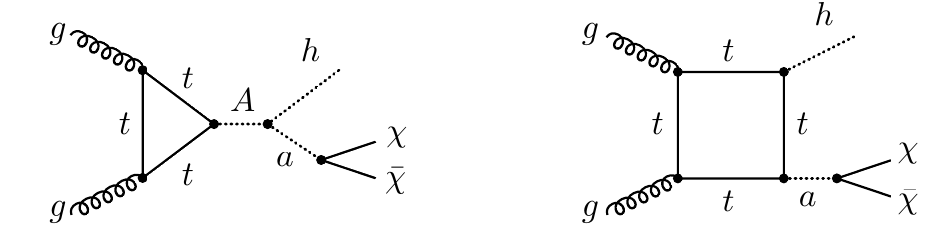
Figure 10 . Sample diagrams in the THDM with an extra pseudoscalar that induce a h + E T; signal in the alignment/decoupling limit. Graphs in which the role of a and A is interchanged can also provide a relevant